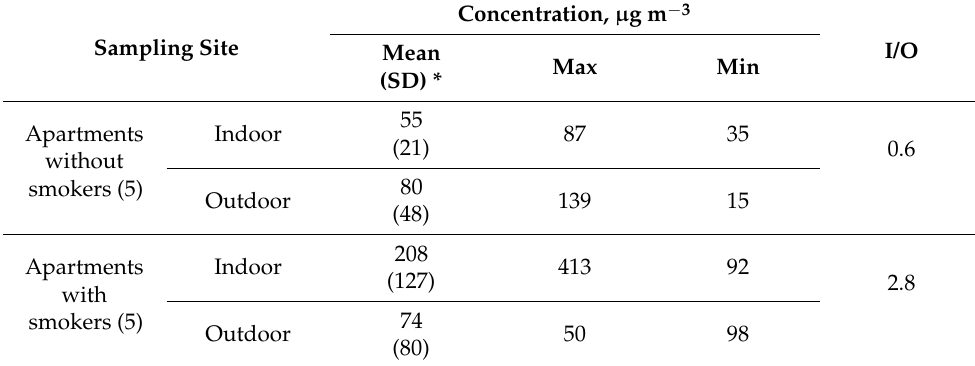
Table 1. Concentration of PM 4 indoors and outdoors for the apartments without and with smoking residents in Katowice.